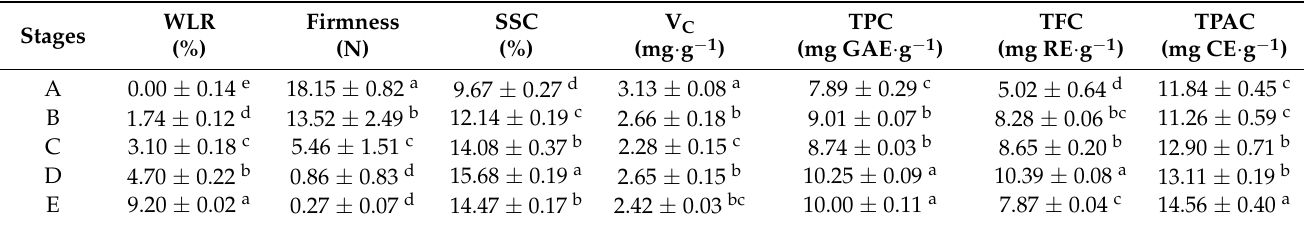
Table 2. Changes in fruit qualities and bioactive ingredients of kiwifruit “Hongshi No. 2” during postharvest